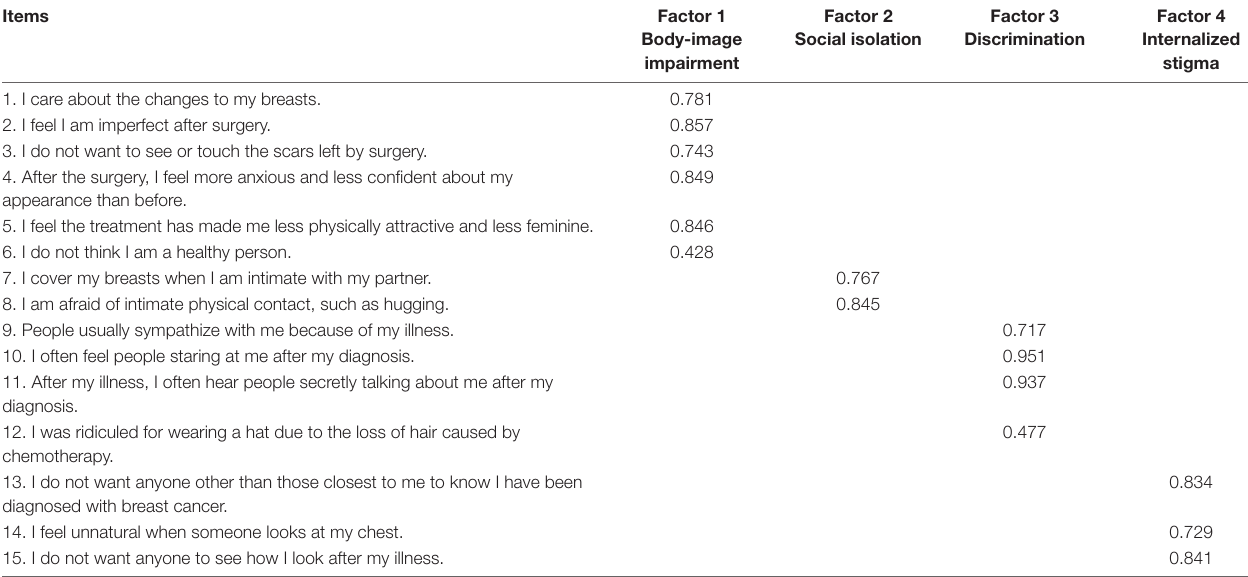
TABLE 3 | Item factor loadings ( n = 200).